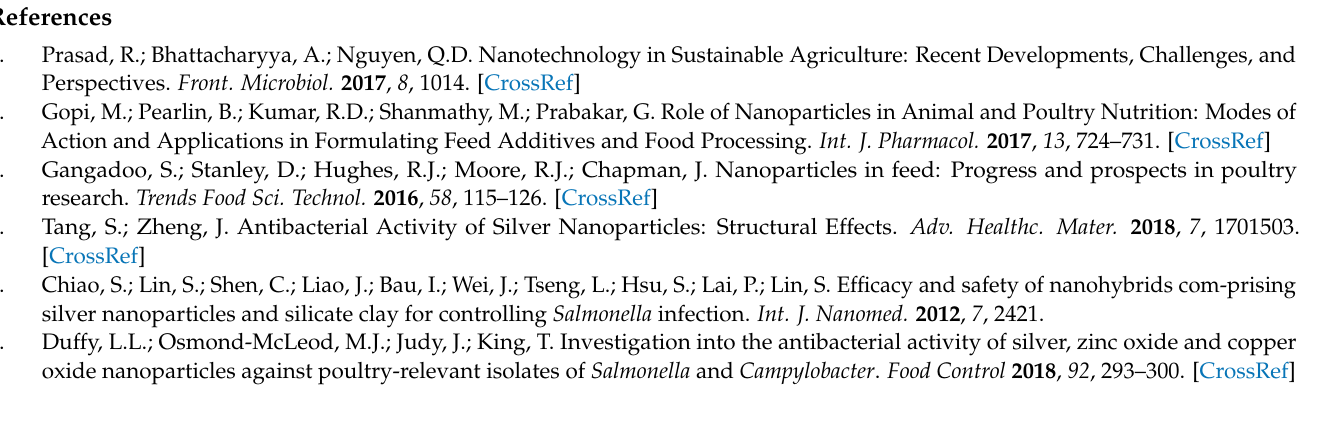
Figure S2: Chicken granulosa cells treated with 50 nm AgNPs for 30